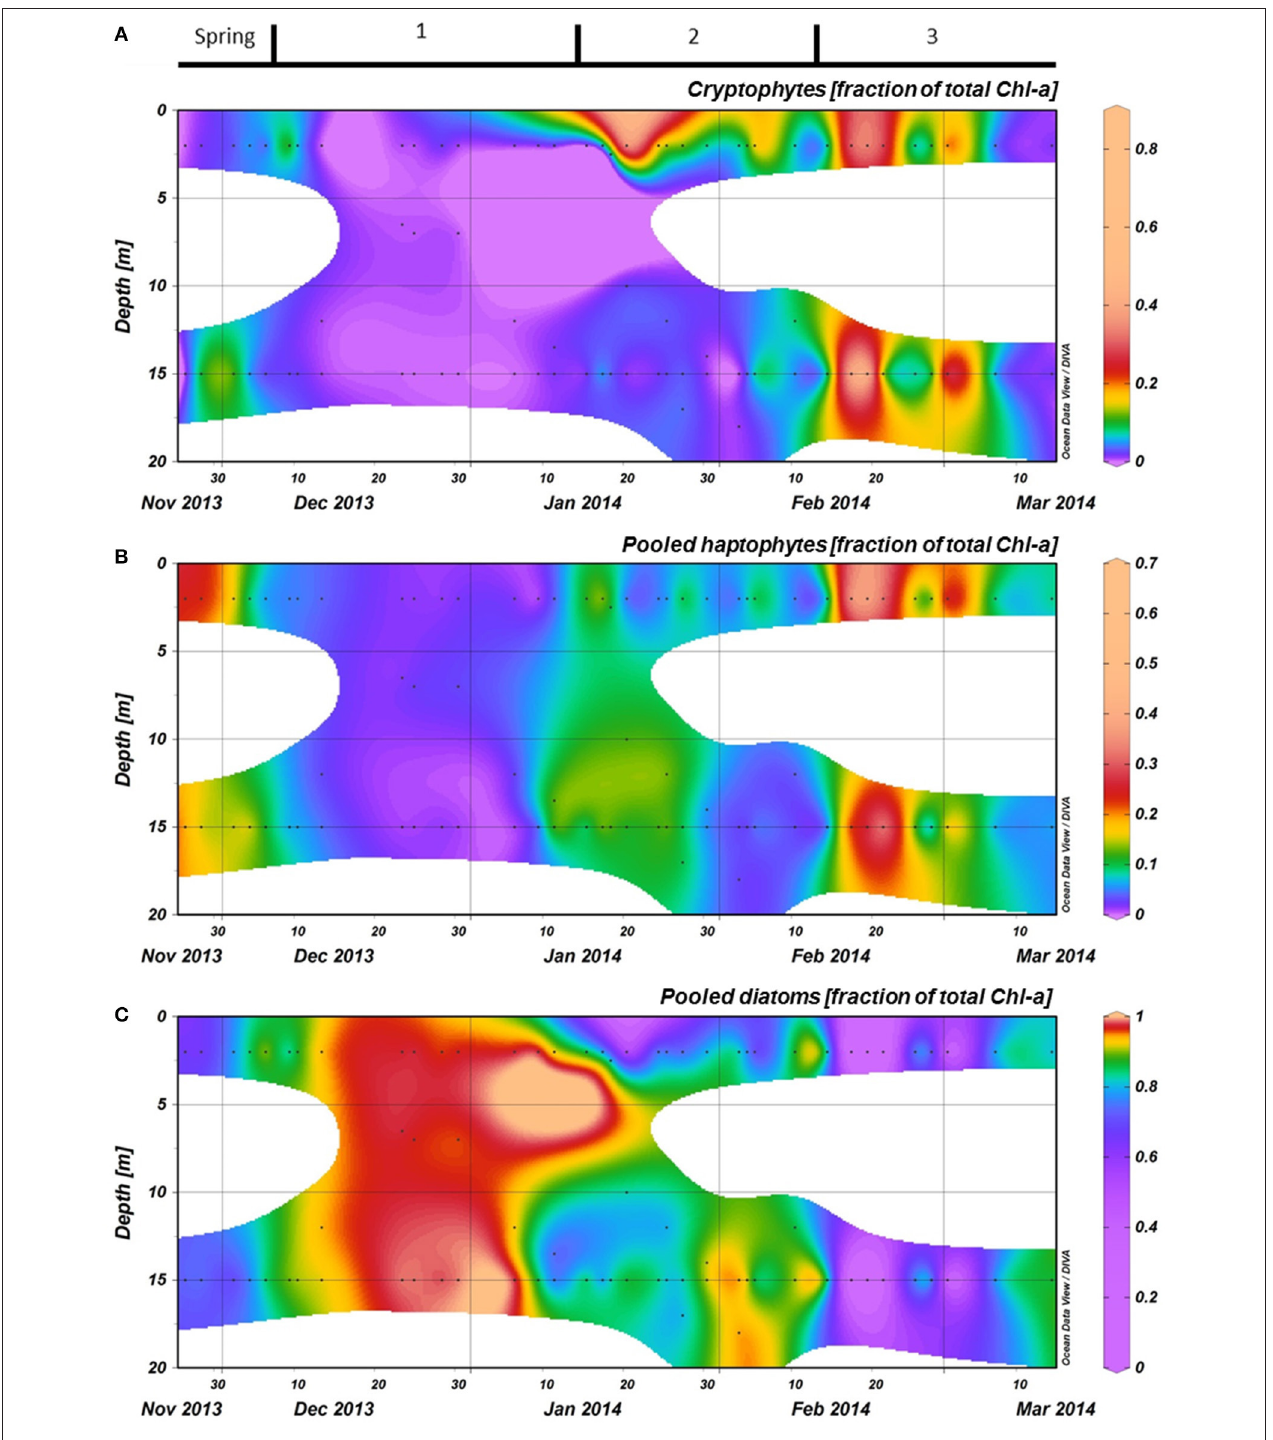
FIGURE 6 | The relative abundances of the three most important phytoplankton groups, as calculated with CHEMTAX using HPLC measurements of pigments, are shown for the top 20 meters at the RaTS site. (A) : Pooled diatoms, (B) : Pooled haptophytes, and (C) : Cryptophytes. Black dots illustrate the sampling depths. Phytoplankton biomass at 75 m was low and only increased to the previous periods (max. 38 and 47%, respectively) and both during the two occasions where strong winds caused a deepening phytoplankton groups co-occurred in the first 15 m ( Table 2 ). of the MLD. Relative group abundance matched those Diatoms were more abundant at the deep fluorescence maxima.